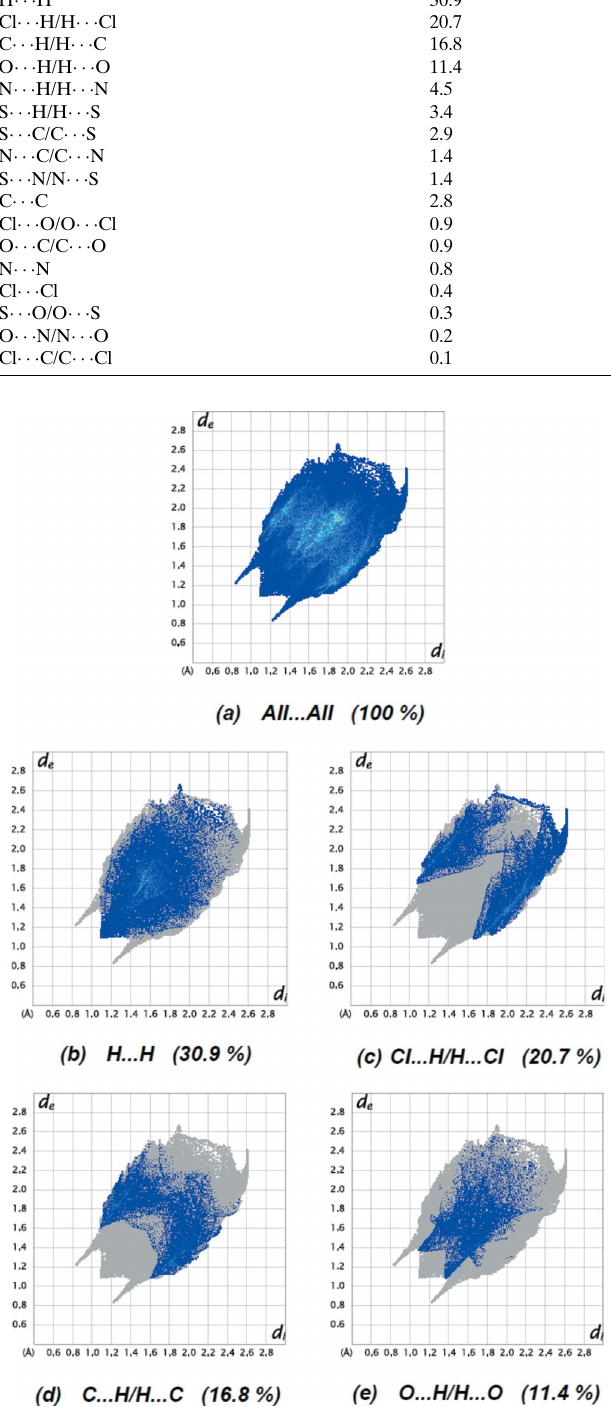
Figure 6 Two-dimensional fingerprint plots for the title compound, showing ( a ) all interactions, and delineated into ( b ) H (cid:2)(cid:2)(cid:2) H, ( c ) Cl (cid:2)(cid:2)(cid:2) H/H (cid:2)(cid:2)(cid:2) Cl, ( d ) C (cid:2)(cid:2)(cid:2) H/H (cid:2)(cid:2)(cid:2) C and ( e ) O (cid:2)(cid:2)(cid:2) H/H (cid:2)(cid:2)(cid:2) O interactions. The d i and d e values are the closest internal and external distances (in A˚ ) from given points on the Hirshfeld